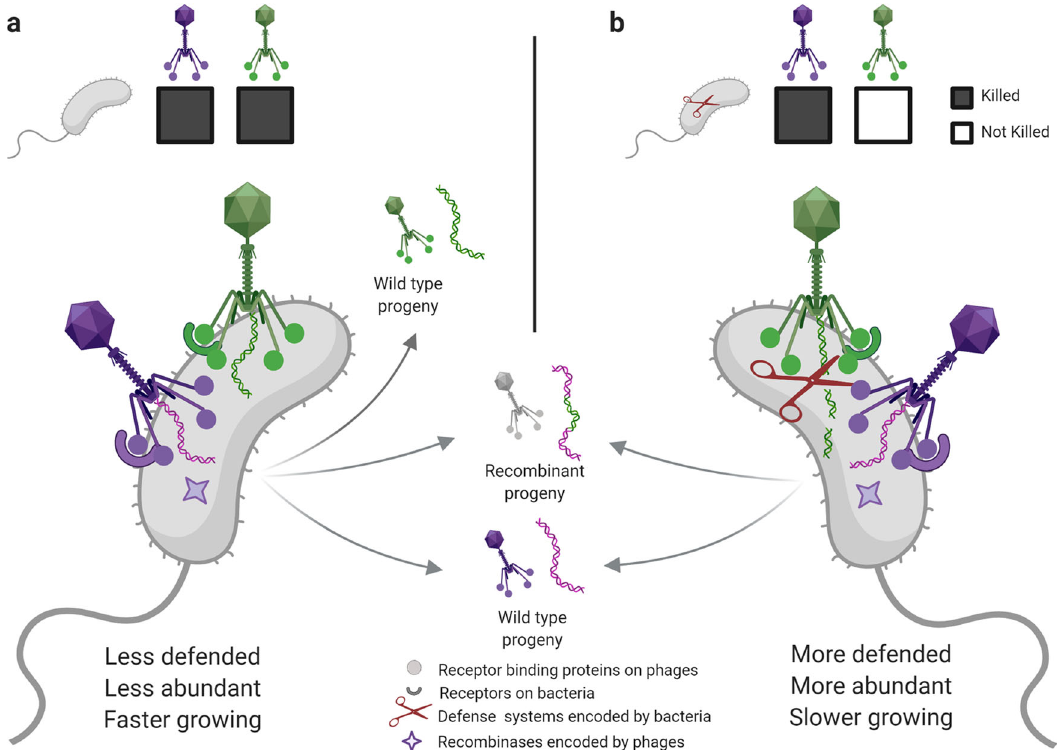
Fig. 7 Cryptic-coinfection models reconcile sparse killing overlap with prevalent recombination in phages. We propose that two classes of cryptic (as in rarely observed in the laboratory) co-infections are key in unifying two at fi rst contradictory observations - that in natural microbial communities overlap in killing is rare among tailed phages, yet recombinant phage genomes are common. First a , co-infections in rarely observed broadly sensitive hosts killed by multiple phage types (indicated by fi lled in squares in the fi gure) may be an important source of phage recombinants in local microbial communities. Where there is an inverse relationship between phage sensitivity and relative abundance and growth rate, broadly sensitive host strains may be ecologically important but systematically underrepresented in isolation studies. Second b , co-infections in commonly observed defended hosts that are only killed by a few phage types (indicated by both fi lled in and empty squares) may also be an important source of recombinant phage progeny, particularly where phage encoded recombinases are expressed in the presence of phage genome fragments generated by host anti-phage defense systems. In both scenarios, where phages are associated with hosts through states of lysogeny or pseudolysogeny, the probability of co-infections, and thus potential for generation of recombinants, will be even greater. Figure created with